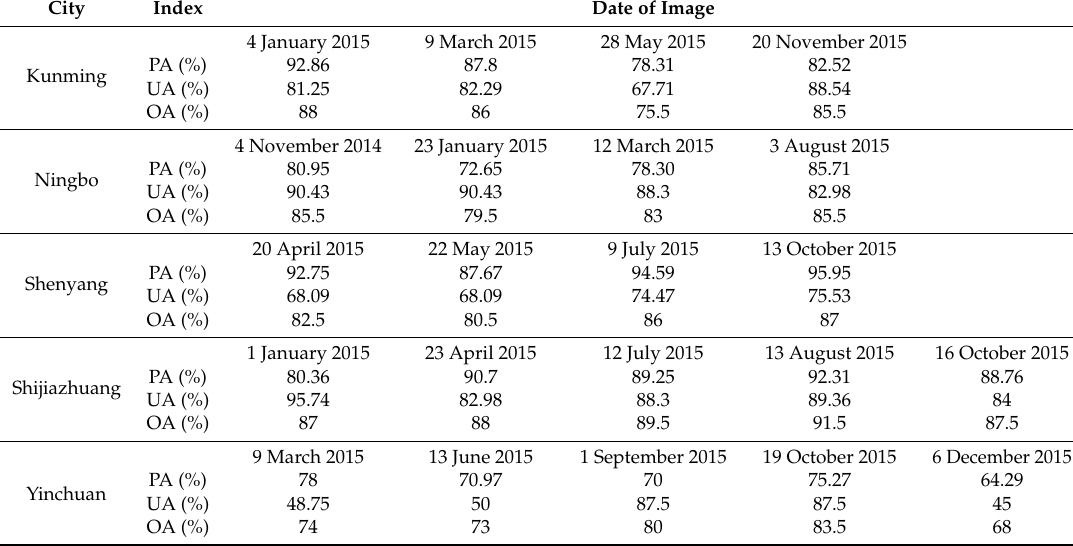
Table 3. Accuracy of impervious surface estimations for each city at different time